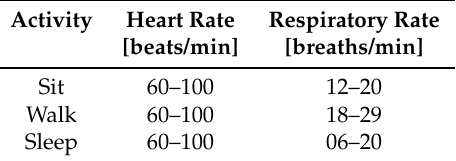
Table 1. Normal Ranges for Heart and Respiratory Rate.